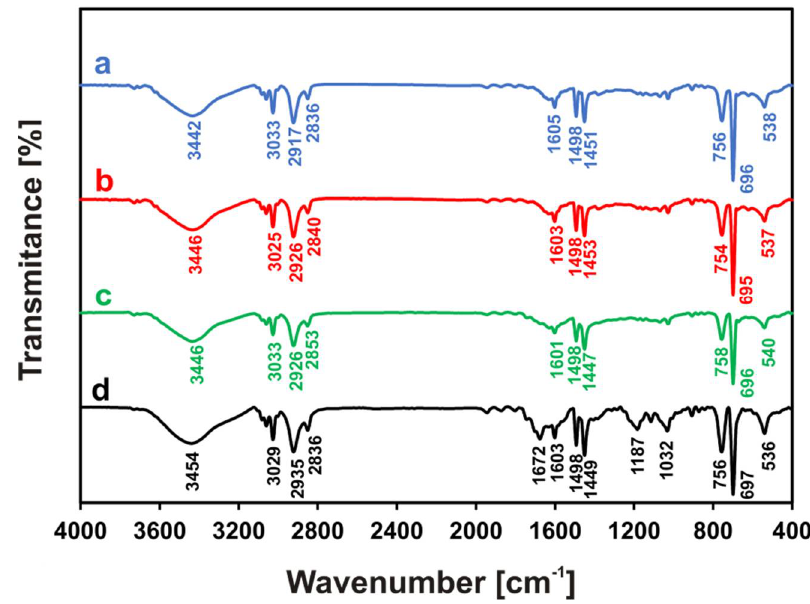
Figure 1. FTIR spectra of ( a ) PS–100, ( b ) PS–200, ( c ) PS–NH 2 –100, and ( d ) PS–NH 2